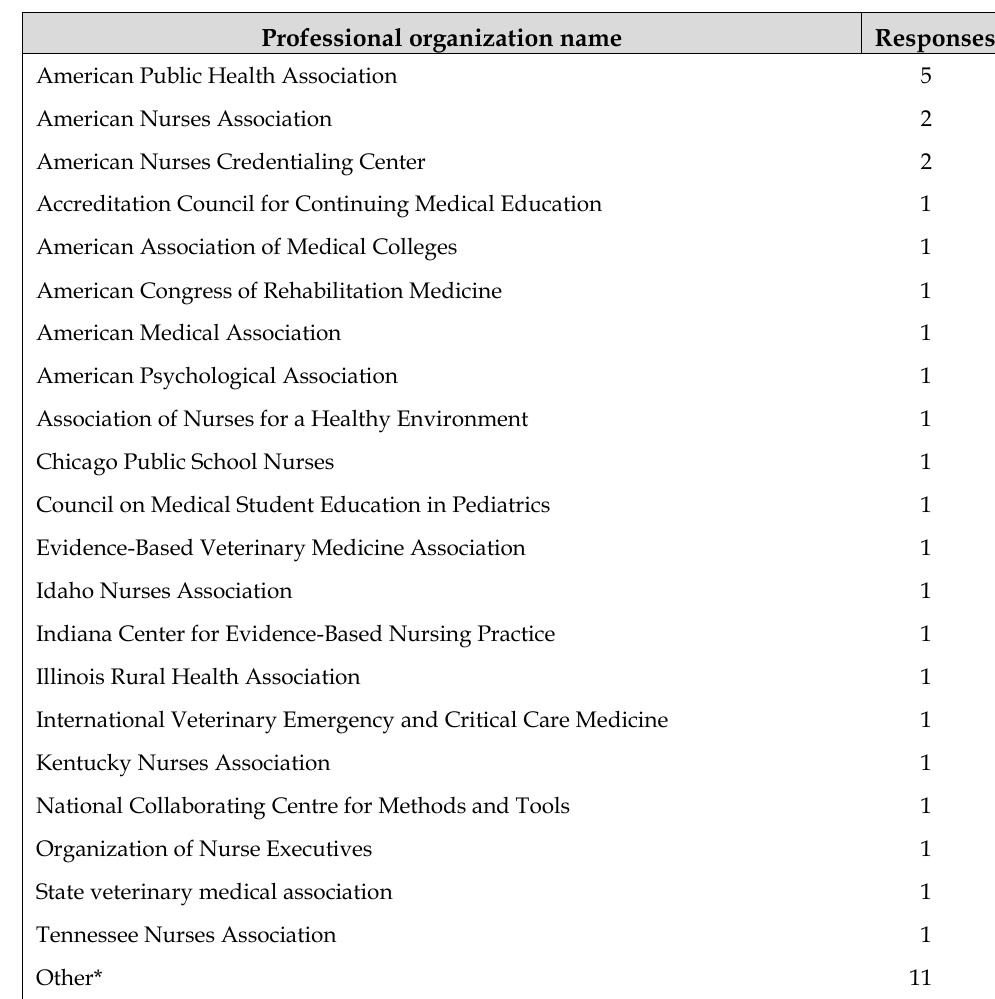
Table 2 Experience teaching for a professional health care organization Professional organization